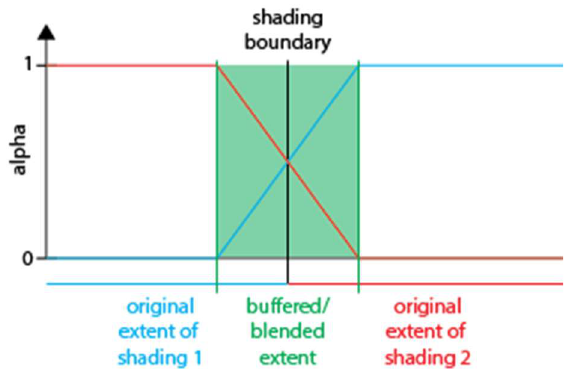
Figure 4. Construction of the transition area when blending two shadings.